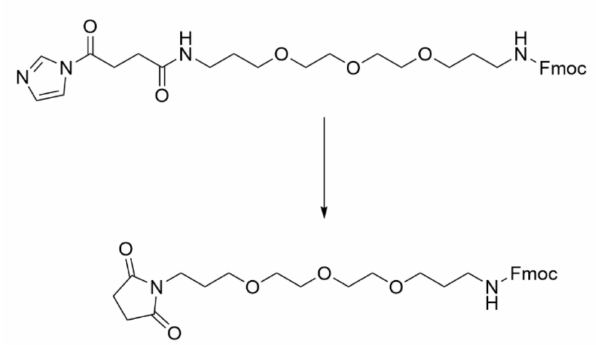
Figure 8. By-product obtained from the cyclization of the CDI-activated succinyl group of com- pound 2